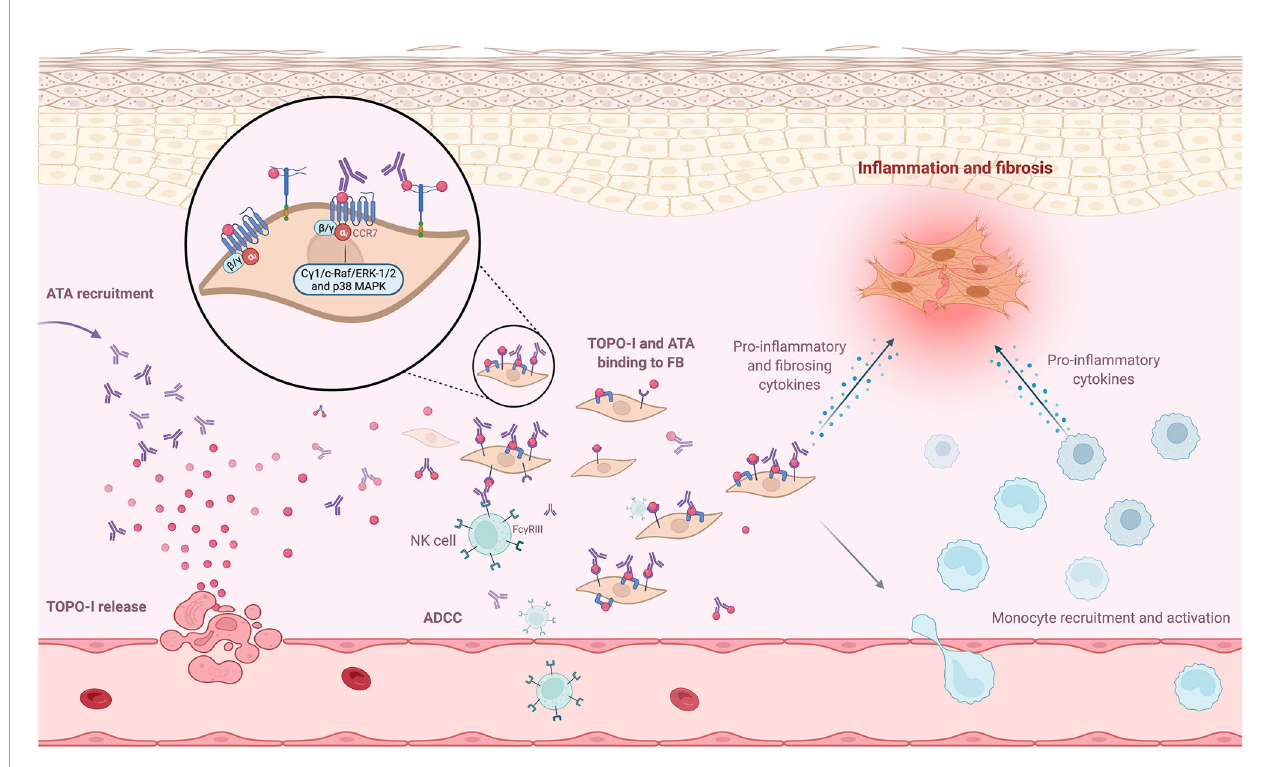
FIGURE 3 | ANA and antigen interaction at cell surface. Neoantigens, such as topoisomerase-I (TOPO-I), are released by apoptotic blebs. TOPO-I bind to CCR7 or proteoglycans at the membrane and are recognized by anti-topoisomerase-I (ATA). This binding recruits ATA at the FB membrane and promotes in fl ammatory and pro fi brotic pathways. The recruitment of more ATA activates monocytes and could promote autoantibody-dependent cell-mediated cytotoxicity